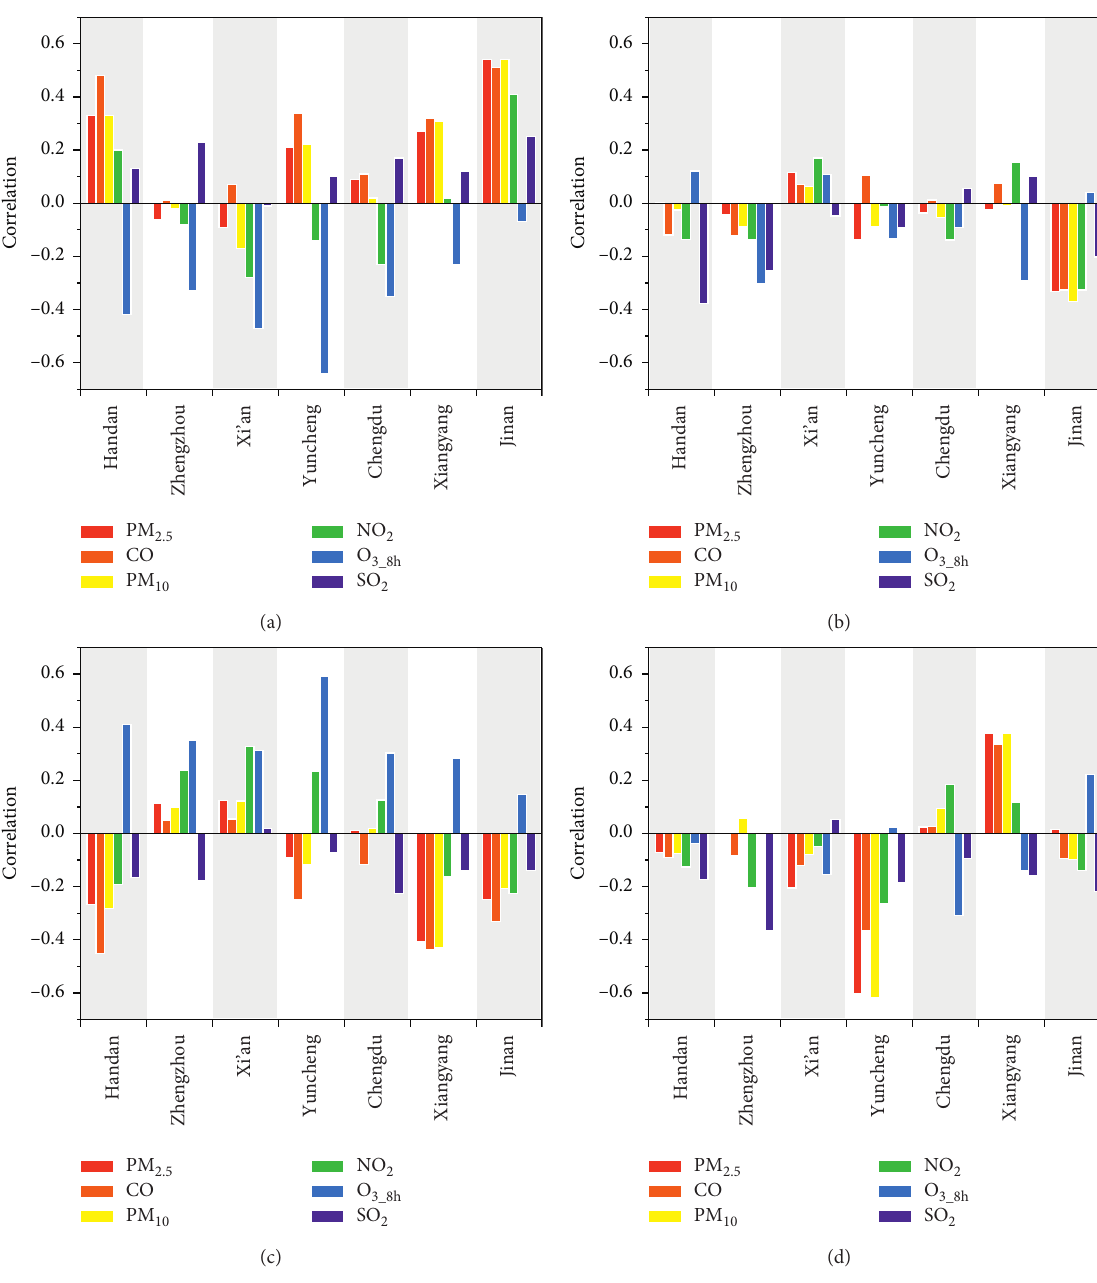
Figure 4: The correlation between pollutant concentrations and temperature (a), wind speed (b), relative humidity (c), and sea-level pressure